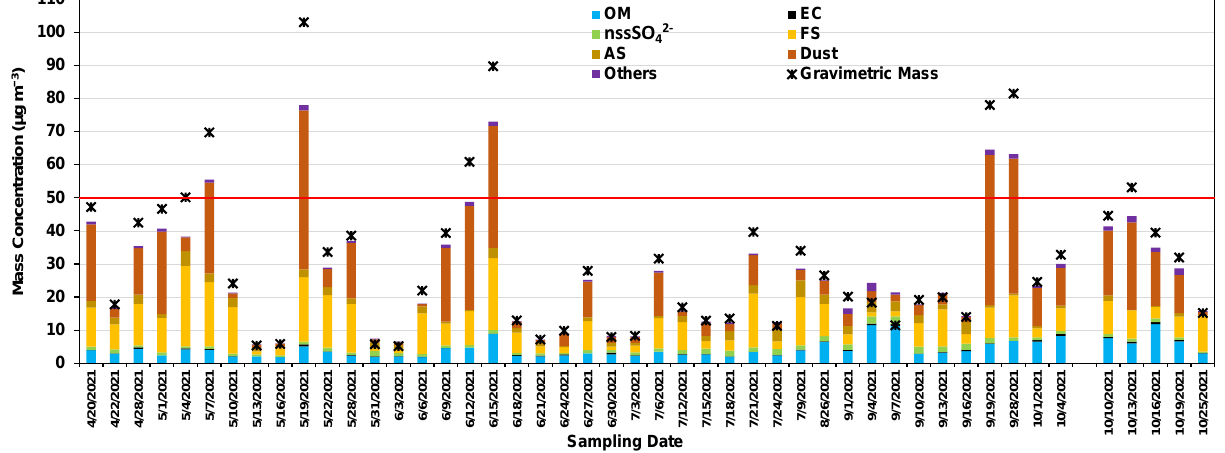
Figure 10. Concentration of PM 10 chemical constituents (stacked bars) and gravimetric mass ( ∗ ) for the days sampled between April and October 2021. The horizontal line represents the state mean 24 h PM 10 standard of 50 μg m −3 .